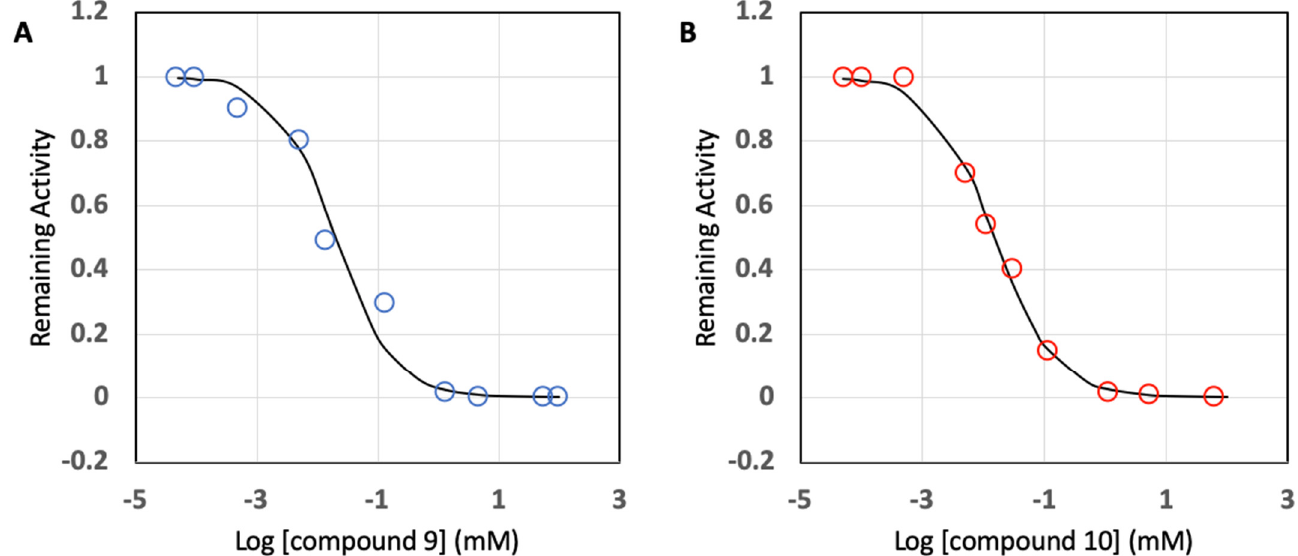
Figure 4. Concentration-response plots for Bla2 inhibition with hydroxamate compounds: Compound 4 ( A ) and Compound 6 ( B ). All data points are based on average values from triplicate analysis. However, the IC 50 value for SAHA was higher than 100 µ M, which is too high to be considered as a drug candidate (Supplemental Figure S2).